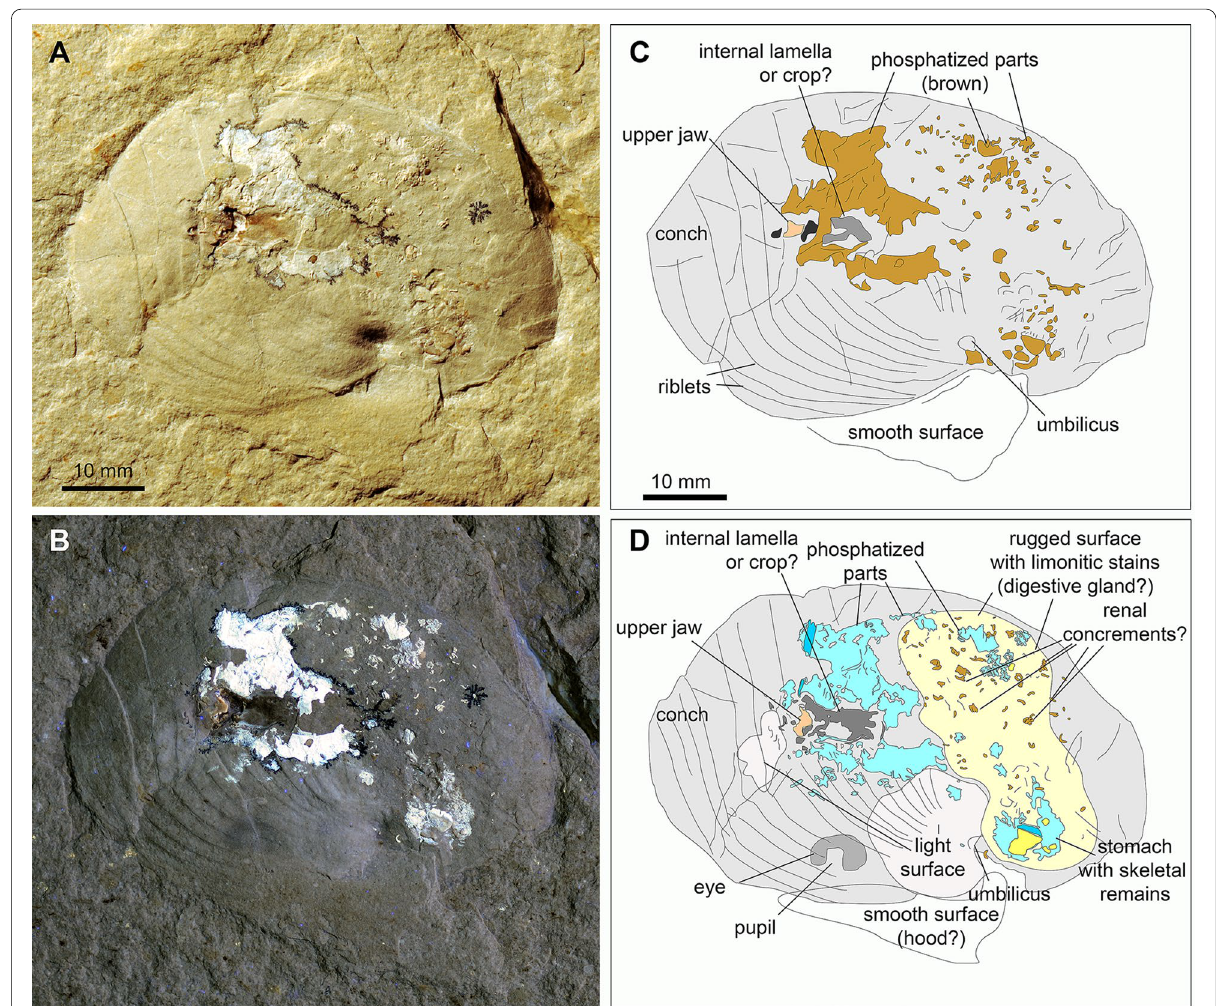
Fig. 1 Flattened conch of Syrionautilus libanoticus with jaws and phosphatised soft parts in situ; PIMUZ 37706, Cenomanian, Hadjoula, Lebanon. All figures have the same scale. A Photo taken under white light; note the ribs and the still discernible umbilicus. B Photo taken under UV-light. C Line drawing of the structures visible in A (light grey—conch imprint without shell material; pink—calcitic part of the upper jaw; dark grey—chitinous wings of the jaws; middle brown—soft part remains with a whitish appearance); the black structures are manganese dendrites and are not drawn. D Line drawing of the structures visible in B (light grey—structures that appear light greyish under UV-light; middle grey—conch remains; dark grey—the supposed eye and formerly chitinous parts of the jaws that appear dark; turquoise—phosphatised structures with a strong fluorescence under UV-light; light yellow—irregular surface with small fluorescing patches as well as dark patches, possibly limonitic; yellow—possibly calcitic